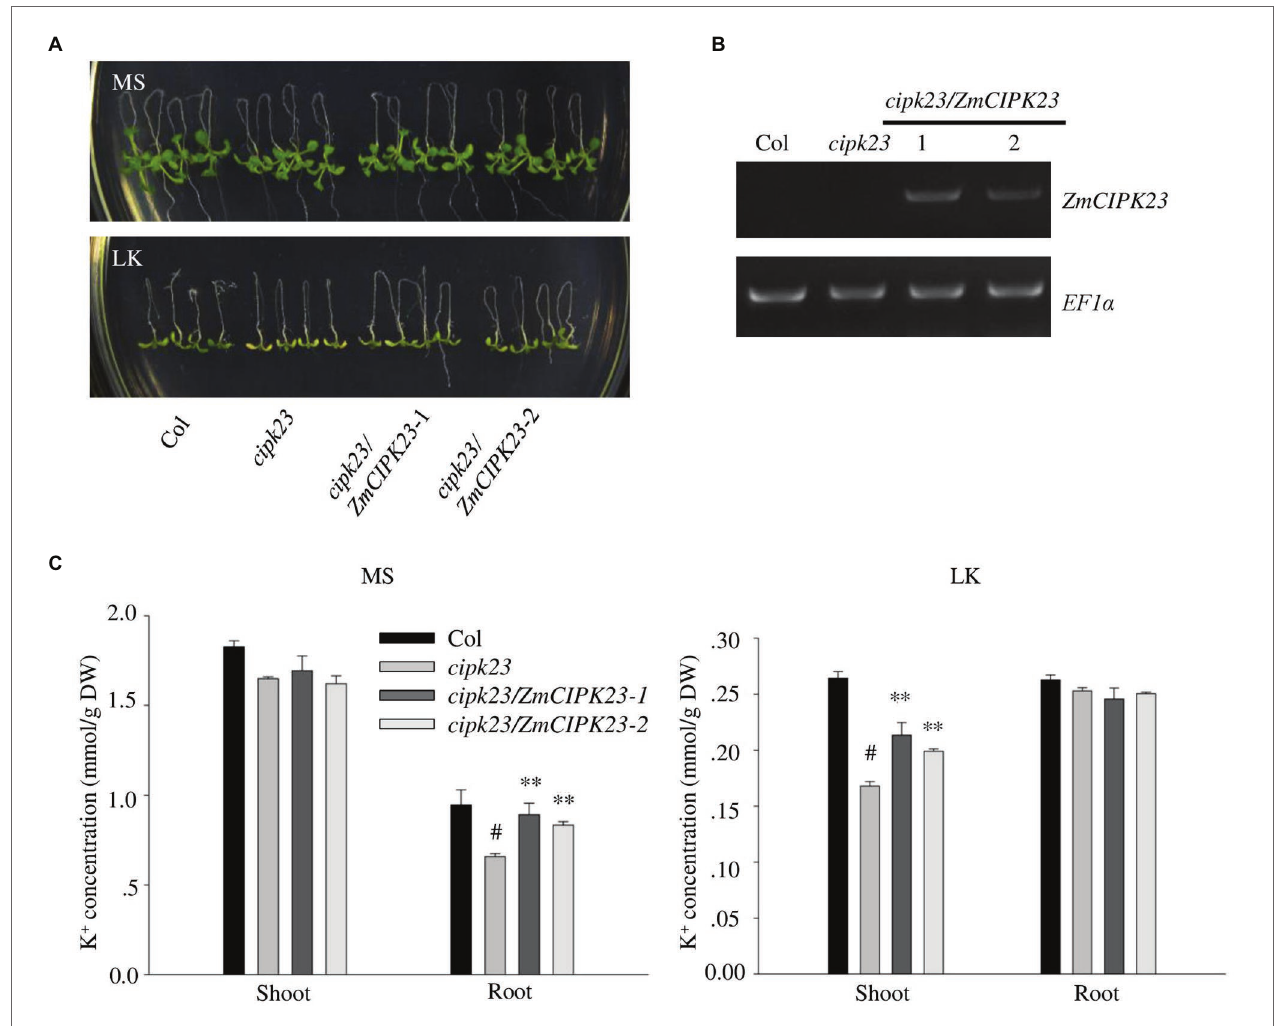
FIGURE 4 | Complementation of Arabidopsis cipk23 mutant by ZmCIPK23. (A) Plant materials grown on MS medium for 4 days were transferred to MS or LK medium for another 7 days. (B) Detection of ZmCIPK23 expression in different plant materials by RT-PCR. EF1a was used as a quantitative